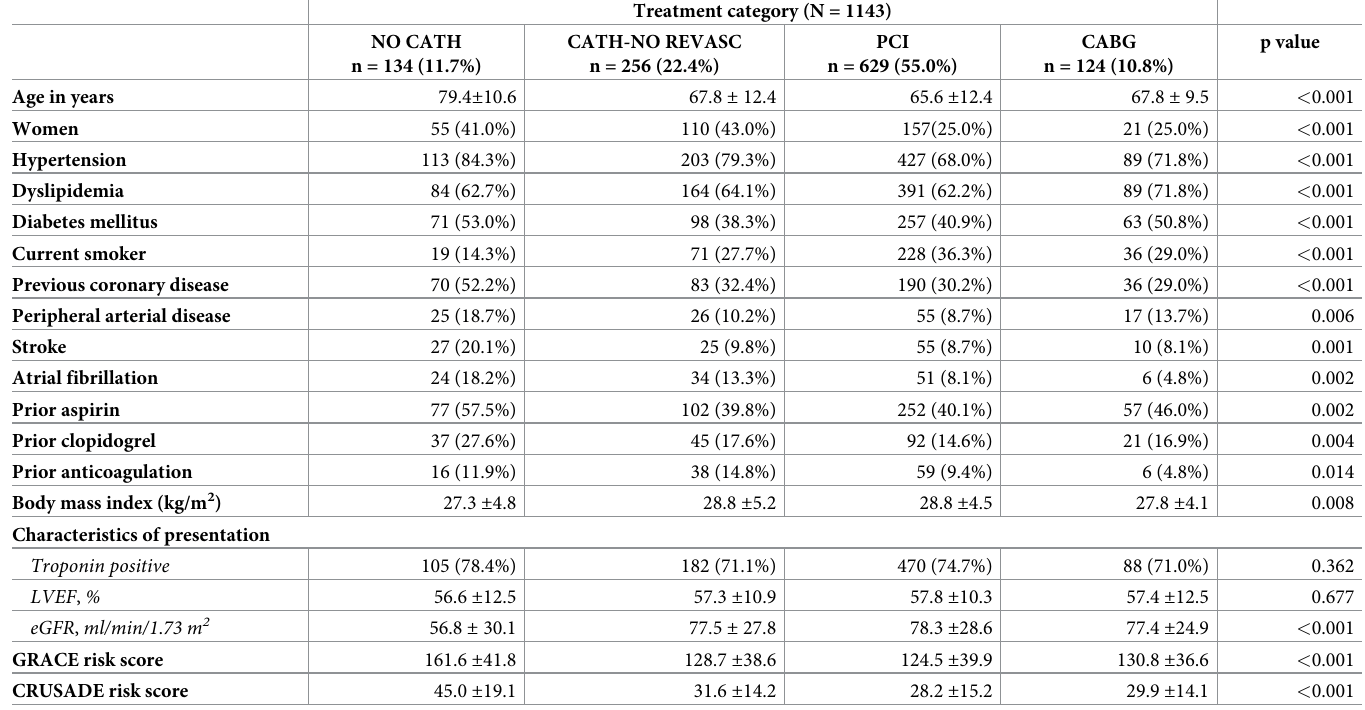
Table 1. Baseline patient